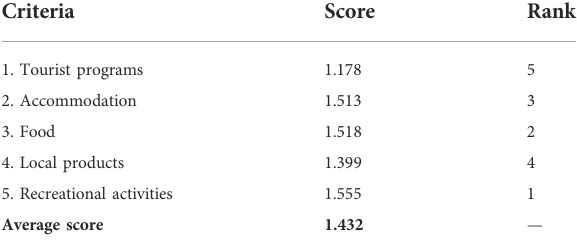
TABLE 6 Scores for the criteria on which the young tourists make the decision to spend their vacation in an ecotourism destination.